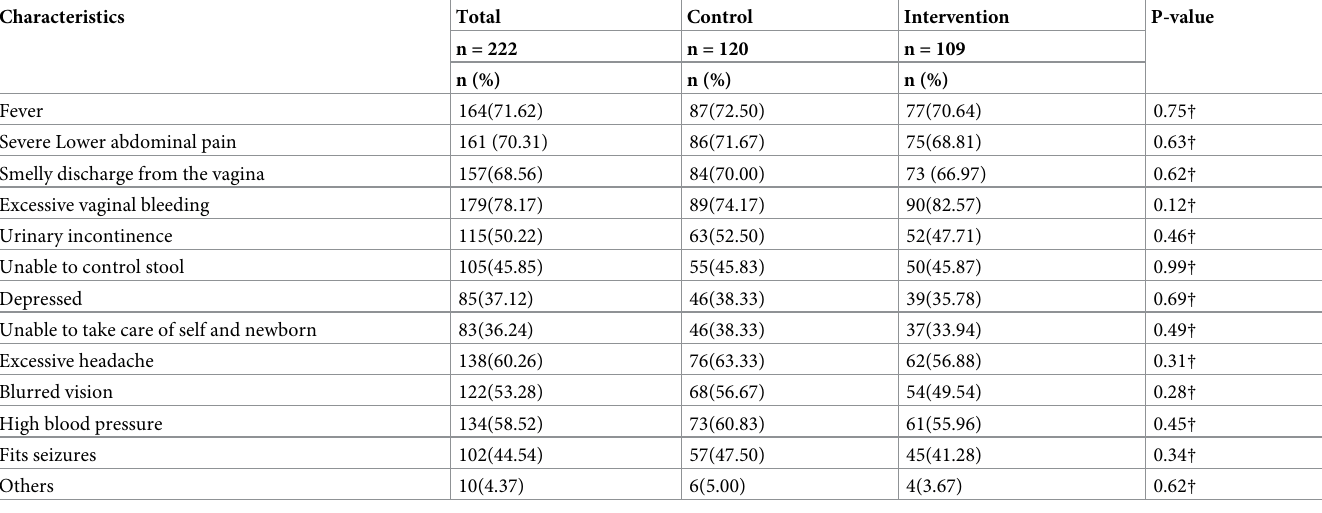
Table 5. Knowledge of danger signs in women during the postnatal period between the intervention and control group at baseline, n = 229.